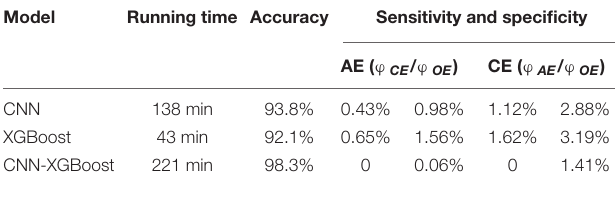
TABLE 2 | Comparison of three different models.